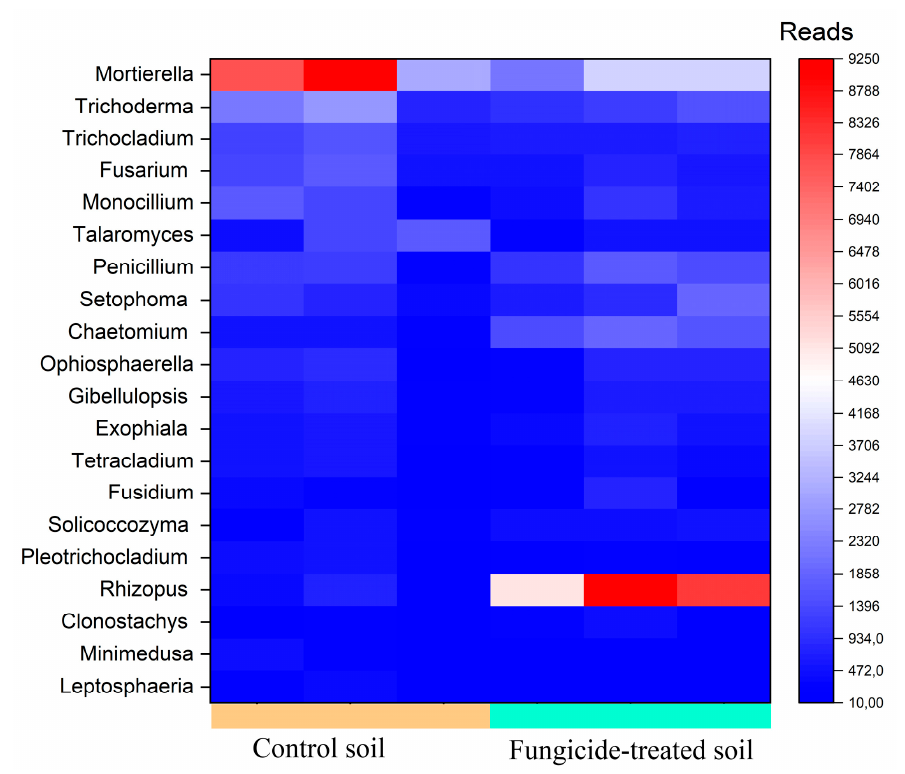
Figure 6. Heatmap of the relative abundance of fungal genera, estimated on the basis of ASV reads.